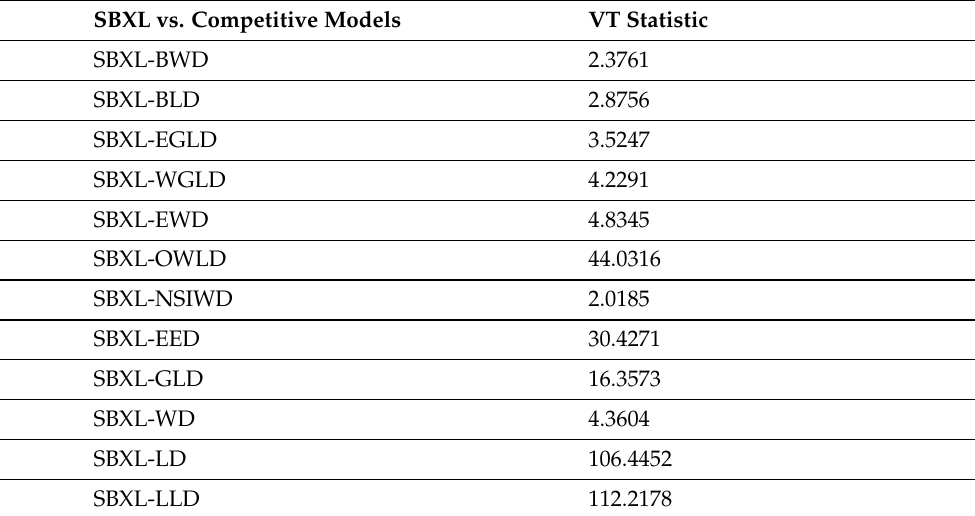
Table 9. Vuong’s test applied on data set-I at Z 0.05 = 1.6495. SBXL vs. Competitive Models